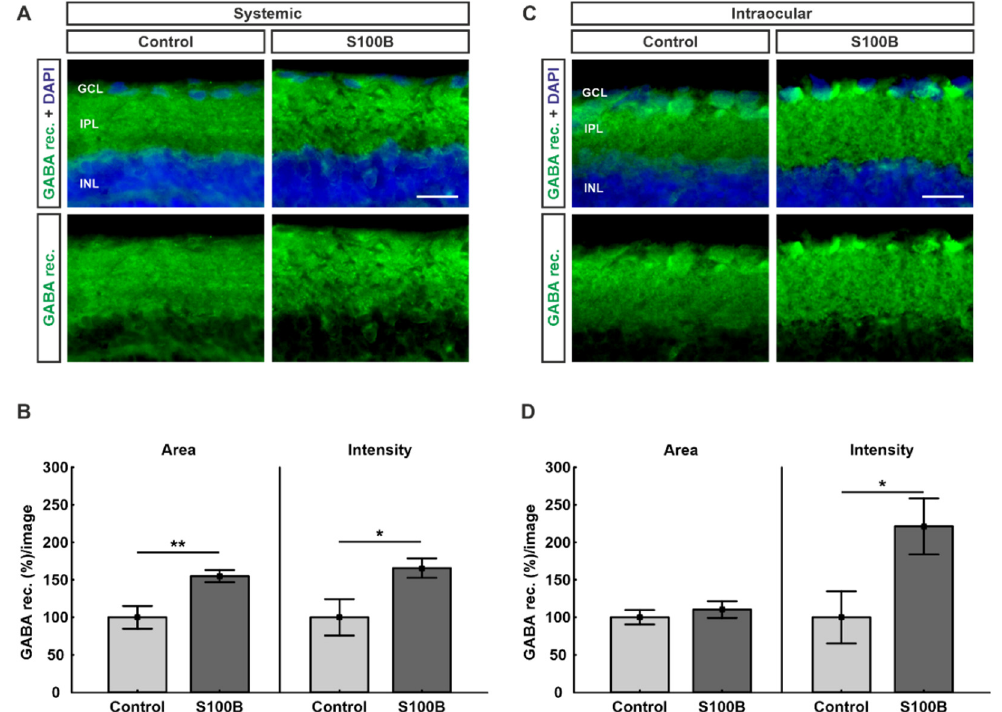
Figure 2. Upregulation of GABA receptors. ( A ) Retinas from animals immunized with S100B ( n = 7/group) were labeled with antibodies against GABA receptors (green). Cell nuclei were stained with DAPI (blue). ( B ) In comparison to controls, the percentages of GABA receptor area ( p = 0.007) and intensity ( p = 0.03) were significantly increased in animals with systemic S100B immunization. ( C ) Retinas from intraocular-injected animals ( n = 7/group) were labeled against GABA receptors (green). DAPI visualized cell nuclei (blue). ( D ) Statistical analyses showed that the intensity of the staining was significantly increased in the intraocular S100B group compared to controls ( p = 0.03). The percentage of labeled area remained unchanged ( p = 0.49). Abbreviations: GCL: ganglion cell layer; IPL: inner plexiform layer; INL: inner nuclear layer; GABA rec.: GABA receptor. Values are mean ± SEM. Scale bars: 20 µm. * p < 0.05, ** p < 0.01.